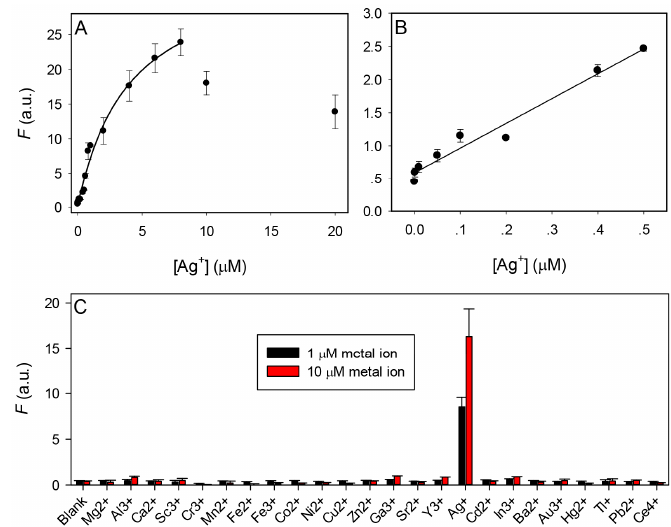
Figure 4. The performance of the G7 DNA (1 µM) and Tb 3+ (5 µM) based sensor for Ag + detection in 50 mM HEPES pH 7.5 buffer. ( A ) Sensor response to various Ag + concentrations; ( B ) The sensor response at low Ag + concentrations; ( C ) Sensor selectivity test at two metal concentrations. Only Ag